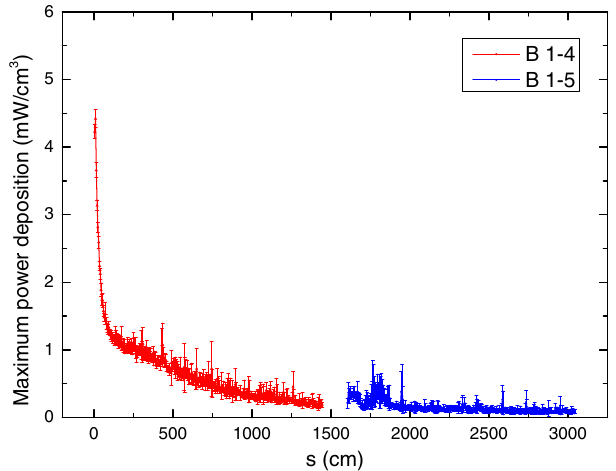
FIG. 17. Maximum power deposition along the two most exposed cold dipoles, which are closest to the first protective